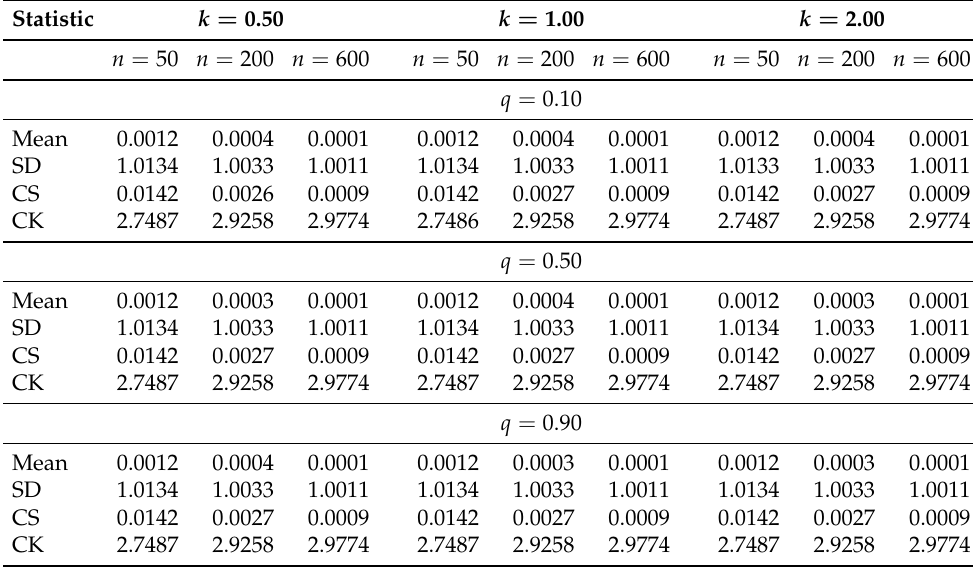
Table 9. Summary statistics of the RQ residuals ( β 0 = 0.5; β 1 =